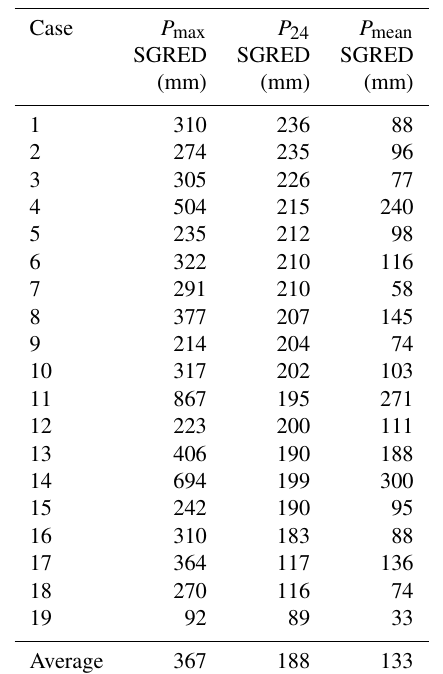
Table 2. Maximum ( P max ), in 24h ( P 24 ) and mean ( P mean ) precip- itation observed in the Gredos Range (SGRED) during each case considered. The P mean has been calculated by the kriging interpo- lation method implemented in the ArcGIS ® software. Case 19 is not taken into account to calculate the average since it was a singu- lar case with little precipitation.